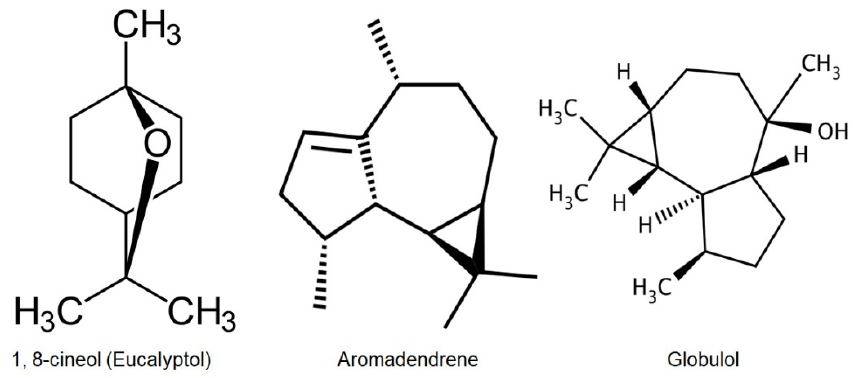
Figure 1. Chemical structures of the main components of Eucalyptus leaf and fruit essential